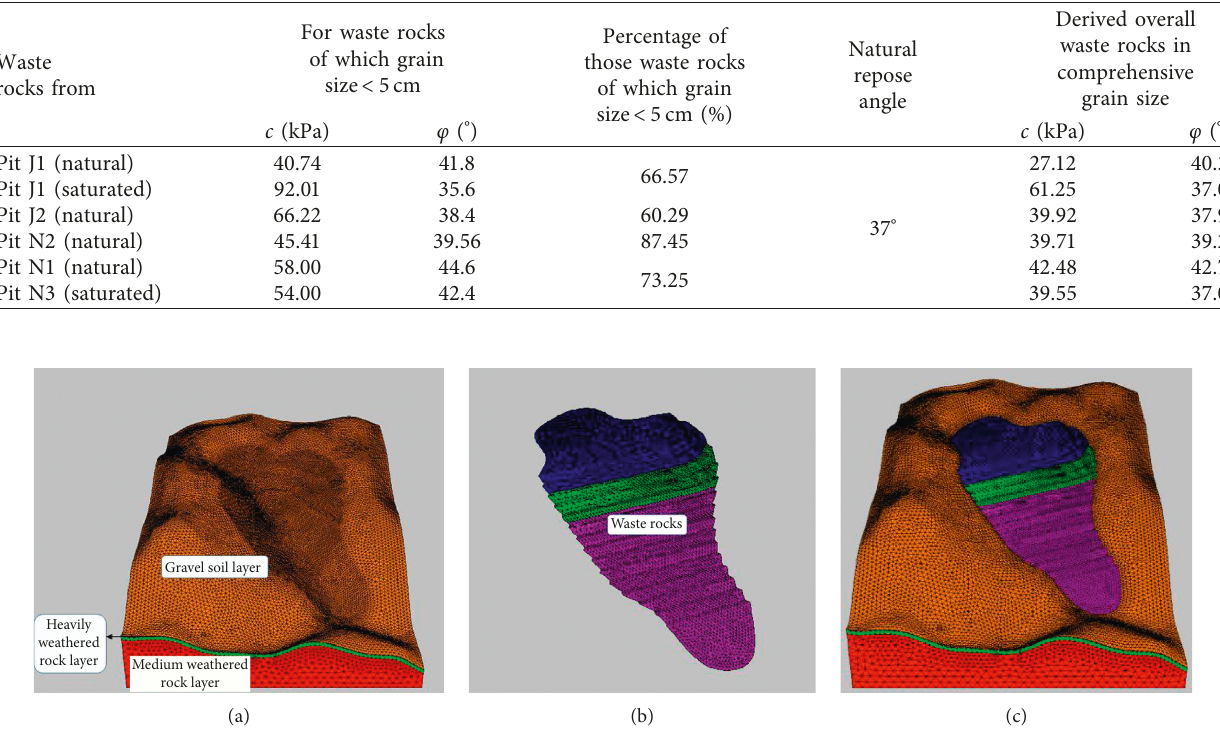
Table 6: Calculation of physical and mechanical parameters of waste